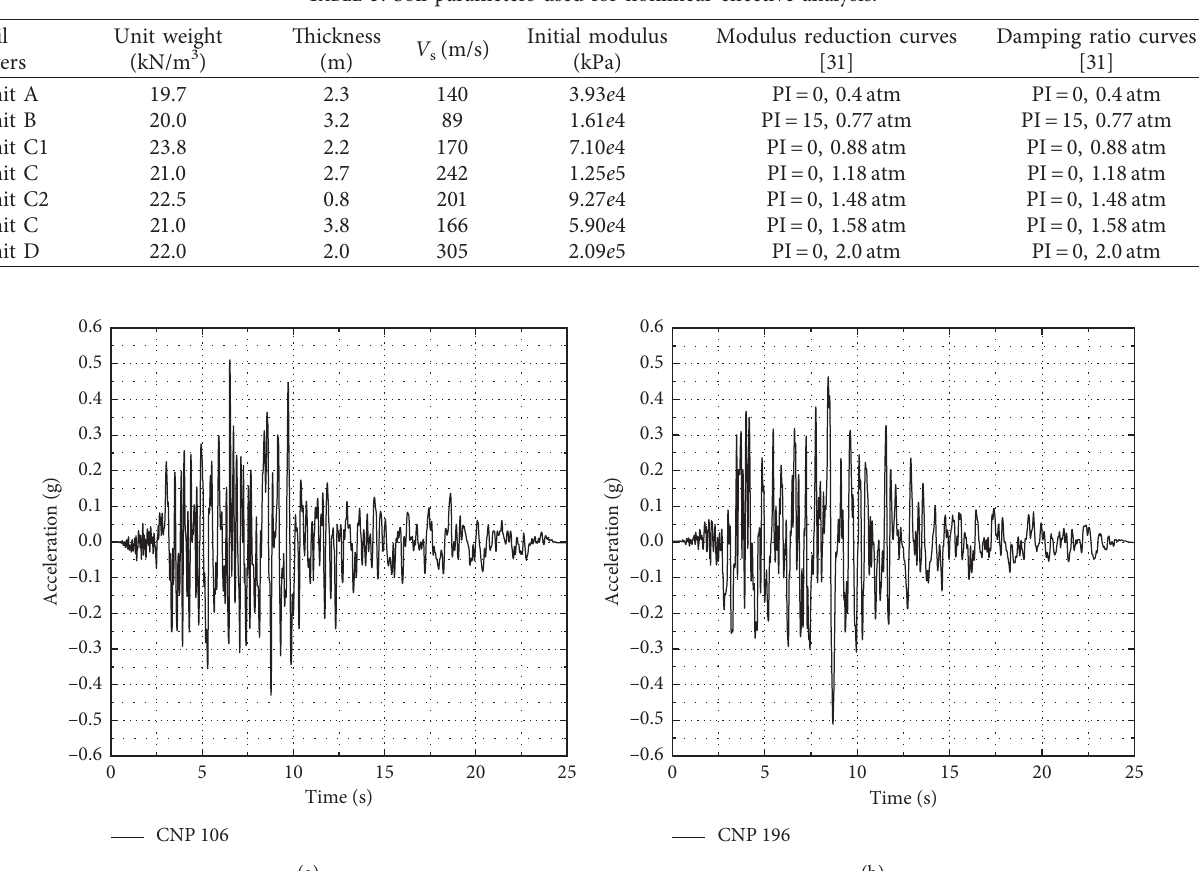
Figure 9: Input motions at the base of the soil profile. (a) CNP 106 and (b) CNP-196.